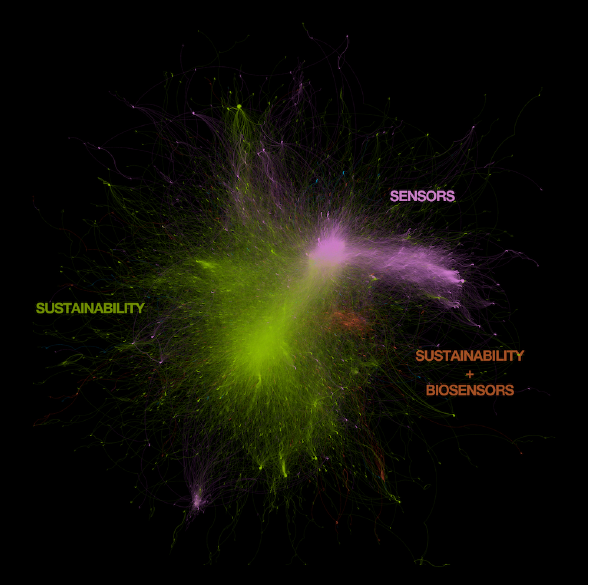
Figure 5. Retweet network as shown in Figure 4. The edges between two users are coloured according to the group of hashtags.